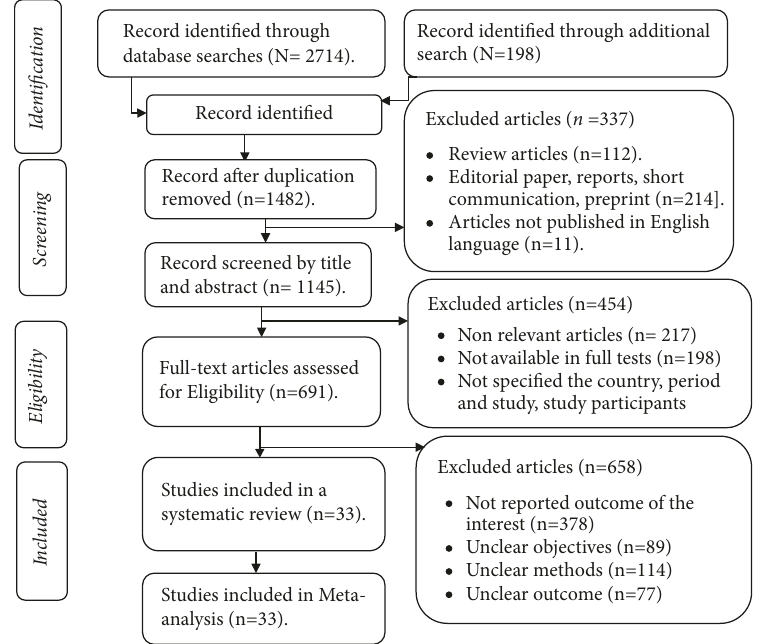
Figure 1: Study selection process of included articles for systematic review and meta-analysis,